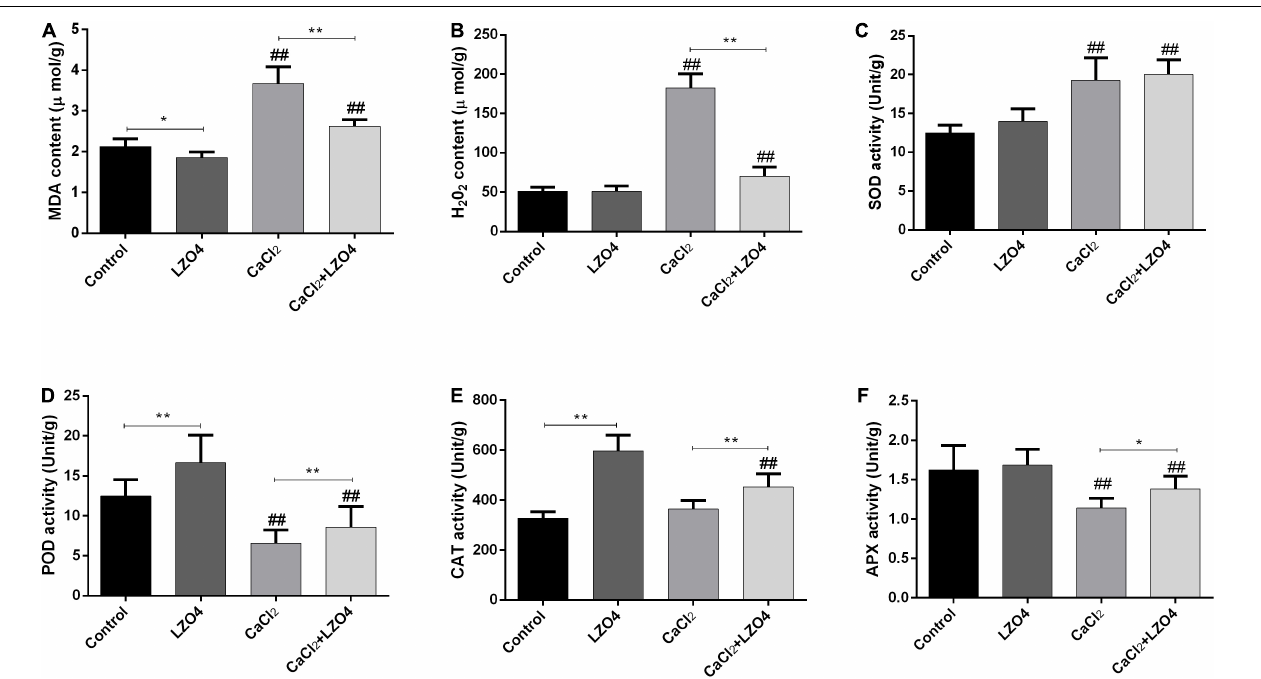
FIGURE 7 | Oxidative stress correlated to products and enzyme activities in A. thaliana roots. (A) The content of MDA ( µ mol/g). (B) The content of H 2 O 2 ( µ mol/g). (C) activity of SOD (Unit/g). (D) The activity of POD (Unit/g). (E) The activity of CAT (Unit/g). (F) The activity of APX (Unit/g). The mean SD ( n = 5) was used to represent the data. * indicates that significant was found ( P < 0.05) vs. control or CaCl 2 groups. ** indicates that significance was found ( P < 0.01) vs. control or CaCl 2 groups; ## indicates that significance was found ( P < 0.01) vs. control or LZ04